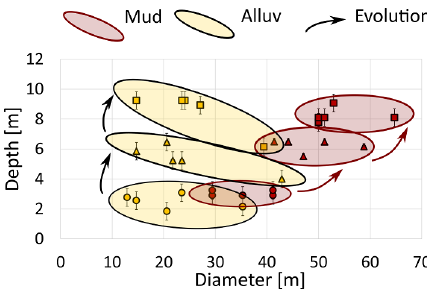
Figure 17. Simulated sinkhole depth / diameter interpretation. The simulations reveal a tendency towards deeper sinkholes in alluvium and both deeper and wider sinkholes in mud, a trend that is able to explain the observations for sinkholes at Ghor